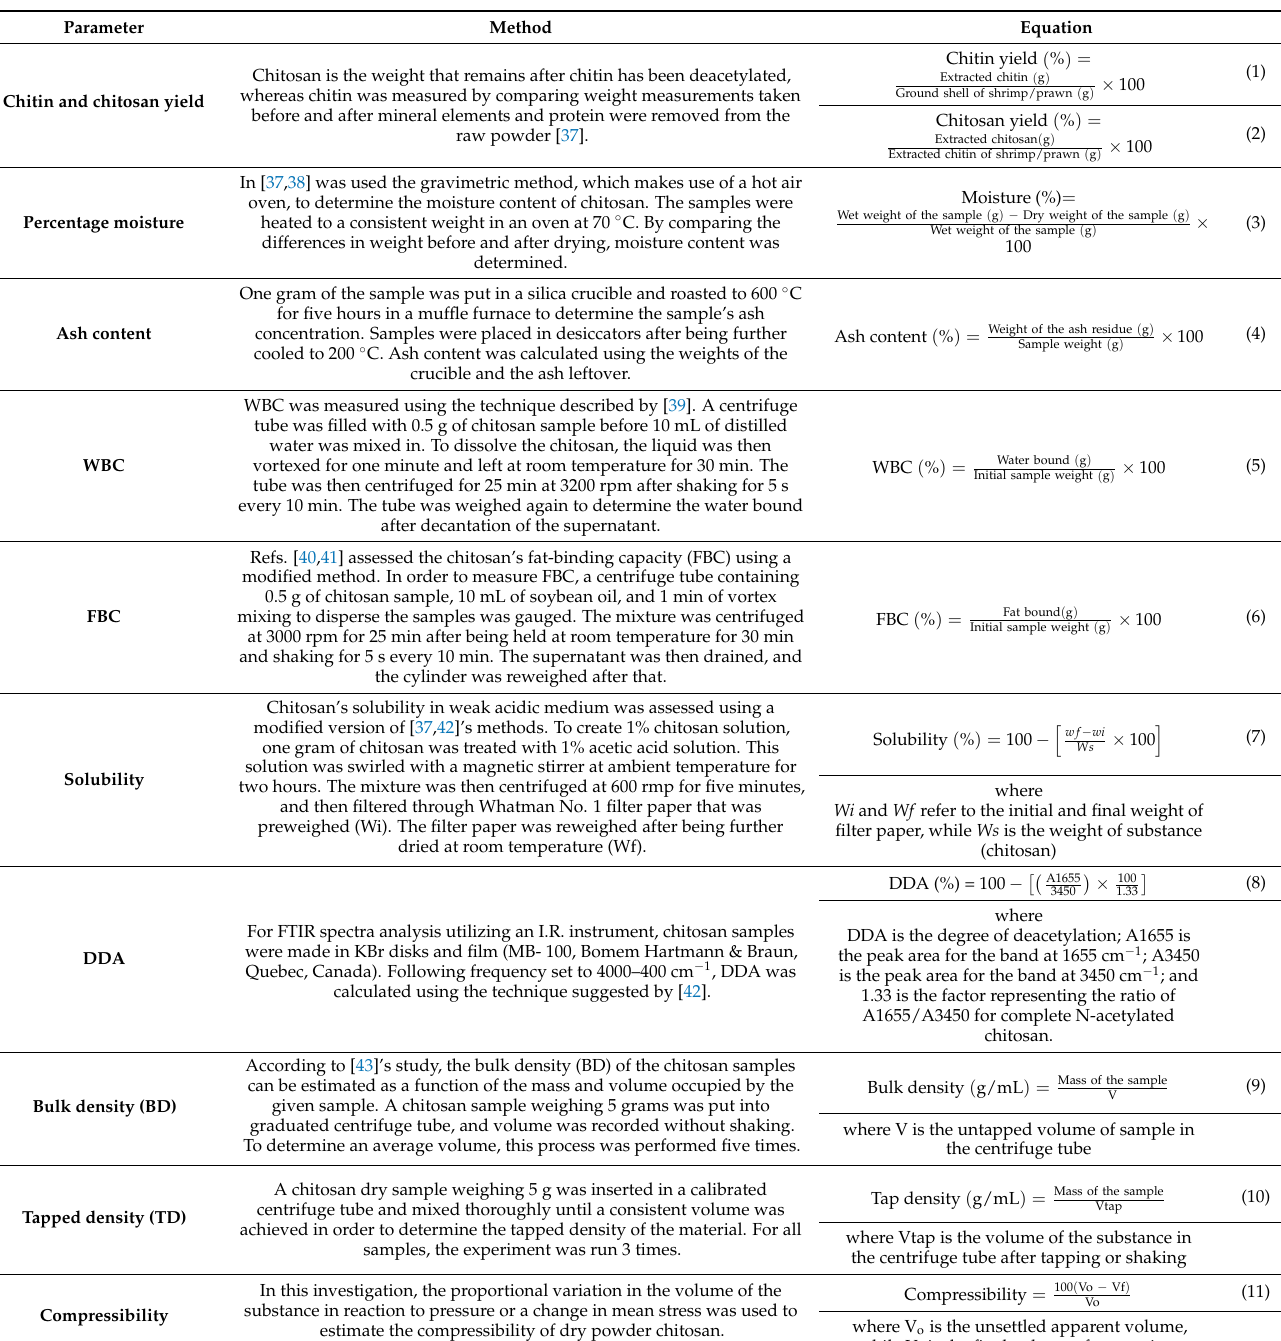
Table 1. Characterization of chitosan from the carapace of M. rosenbergii. Adapted from